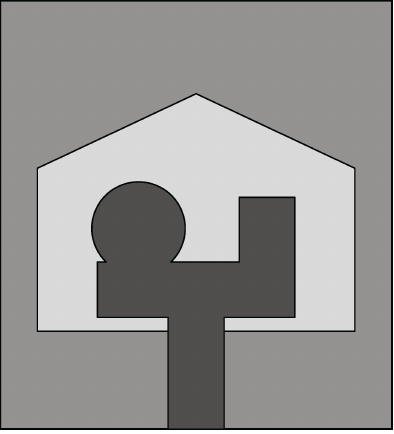
Figure 27. Design of the compact hut-shaped slot antenna (redrawn from [102]). Dark gray top metal face, medium gray bottom metal face, and light gray dielectric